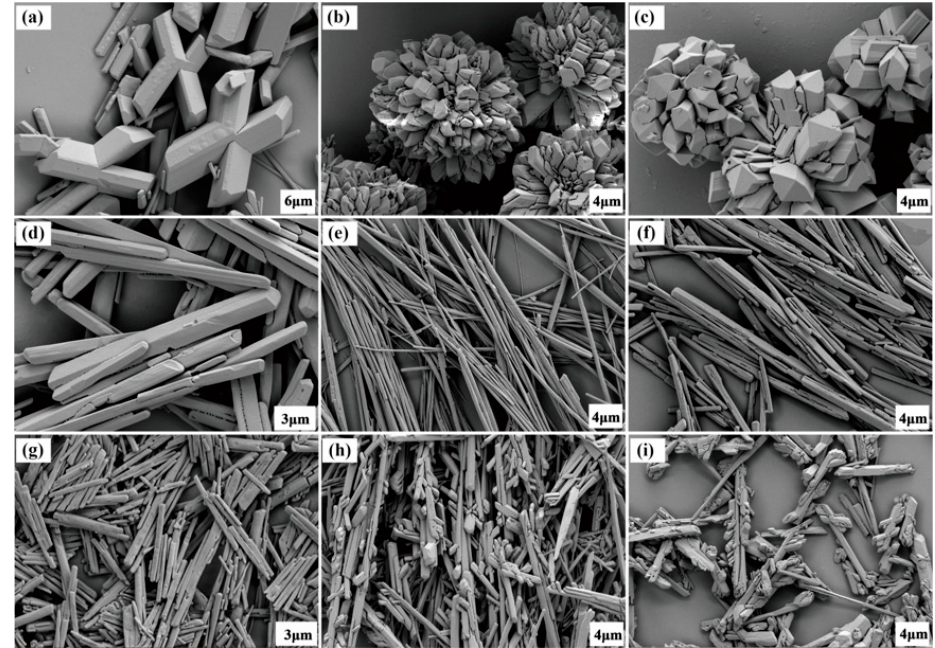
Figure 2. Scanning electron microscopy (SEM) images of LLM-105 crystals obtained by varying antisolvent. ( a ) Water, ( b ) methanol, ( c ) acetic acid, ( d ) nitromethane, ( e ) ethyl acetate, ( f ) ethanol, ( g ) methylene chloride, ( h ) o-dichlorobenzene, and ( i ) toluene.